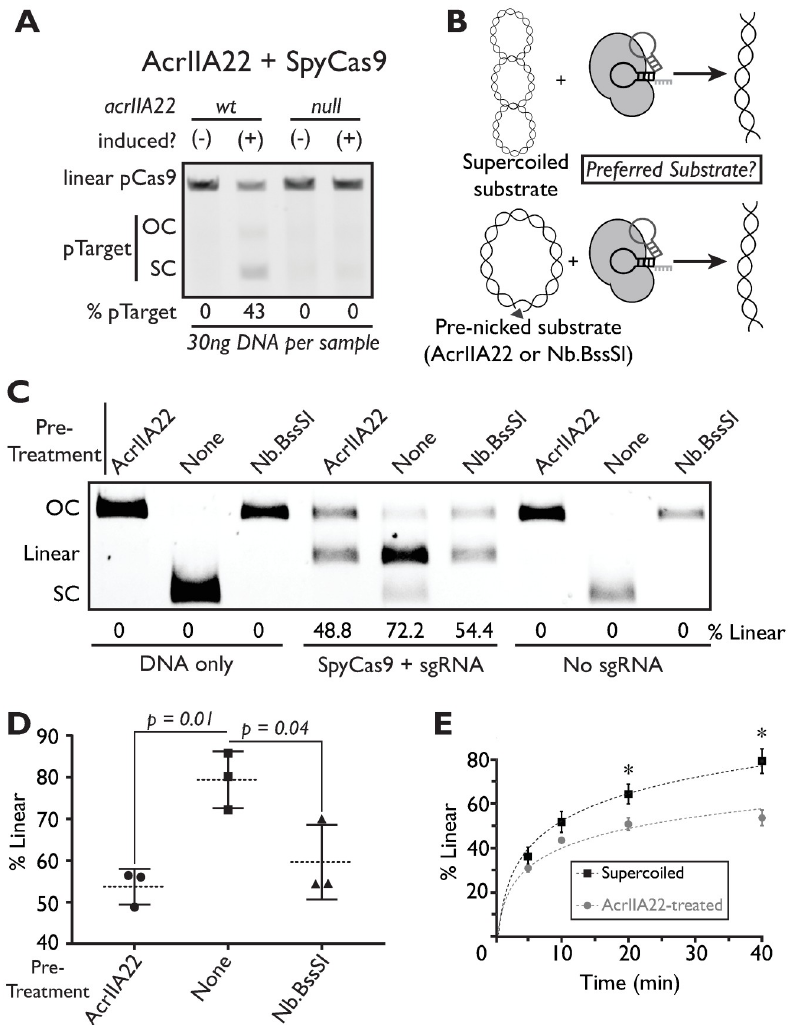
Fig 7. Nicking by AcrIIA22 protects plasmids from SpyCas9 in vivo and in vitro. ( A ) Gel electrophoresis of plasmids purified from overnight E . coli cultures expressing either wild-type acrIIA22 or a mutant with an early stop codon (“null”). In these cultures, SpyCas9 was expressed from a second plasmid, which was linearized via a unique restriction site before electrophoresis. The acrIIA22 -encoding plasmids are indicated with the “pTarget” label. The “% pTarget” figure indicates the fraction of total DNA attributable to pTarget, quantified by densitometry analysis. In cases with complete pTarget elimination, all DNA comes from the SpyCas9 expression plasmid, and thus these bands are more pronounced. However, in the presence of wild-type acrIIA22, pTarget is protected from SpyCas9-mediated cleavage and makes up 43% of total plasmid DNA. ( B ) We present a schematic of the experimental design for the data depicted in panel C. The experiment tests whether SpyCas9 preferentially cleaves an SC or OC plasmid target in vitro. Though both plasmid substrates will be linearized following SpyCas9 cleavage, linear DNA will accumulate more readily with a preferred substrate. ( C ) Plasmid purifications from overnight cultures were either left unmodified or pretreated with one of 2 nickase enzymes, AcrIIA22 or Nb.BssSI, following which each substrate was digested with SpyCas9 in vitro. The percentage of DNA in the linear form is quantified below the gel, which indicates complete SpyCas9 cleavage. Linear, OC, and SC plasmid forms are indicated along with the left of the gel and reaction components below the gel. SpyCas9 cuts DNA strands sequentially; incomplete digestions with supercoiled substrates produce OC plasmids if only one strand has been cleaved (e.g., lane 5). Prenicked plasmids, by either AcrIIA22 or Nb. BssSI, are less susceptible to linearization via SpyCas9 cleavage. ( D ) Endpoint measurements indicate that SpyCas9 more efficiently linearizes SC plasmids than substrates nicked with either AcrIIA22 or Nb.BssSI (Student t test, n = 3). ( E ) A time course experiment demonstrates that SpyCas9 more efficiently linearizes supercoiled plasmids than AcrIIA22-treated substrates. An asterisk ( � ) denotes significant differences between AcrIIA22-treated and untreated substrates (Student t test, p < 0.05, n = 3). The individual numerical values and original images for the data presented in this figure may be found in S1 Data and S1 Raw Images, respectively. OC, open-circle; SC, supercoiled; SpyCas9, Streptococcus pyogenes